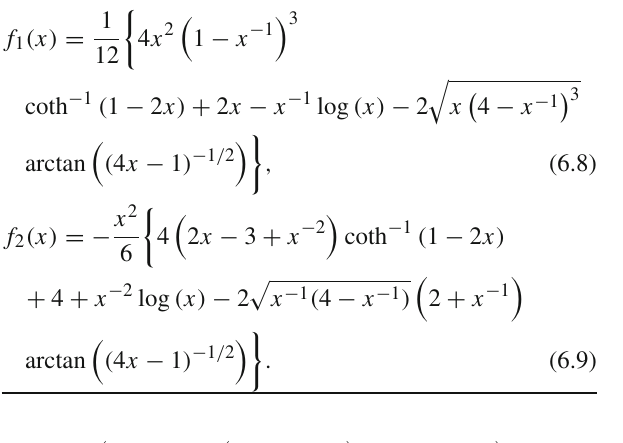
Fig. 9 Thermallyaveragedannihilationcrosssectionmultipliedbythe into neutrinos assuming the same set of model parameters. The right panel displays the indirect detection constraints coming from Planck relative velocity for DM annihilation into e + e − , μ + μ − , and τ + τ − . We : m = 1 : 3 : 6, g (cid:9) = 1, θ = 0 . 031, and θ μ,τ = 0. and Fermi-LAT. The lower bound m χ (cid:3) 10 MeV is set by observations have fixed m χ : m Z e 4 2 The left panel provides comparison with (cid:2) σv r (cid:3) for DM annihilation of the CMB and BBN. See text for further